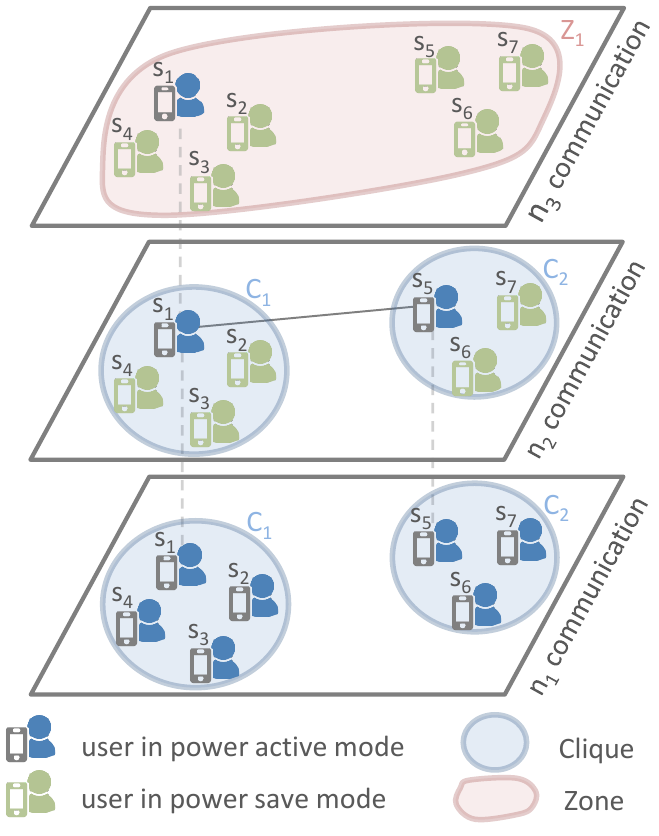
Figure 1. Layer communication